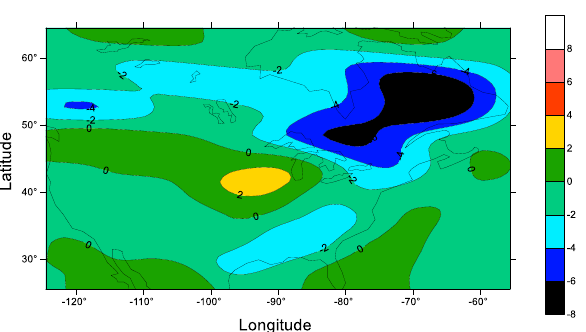
Figure 7. Mascon solution for the trend rates of the separated GWS changes in North America (x10 -3 m